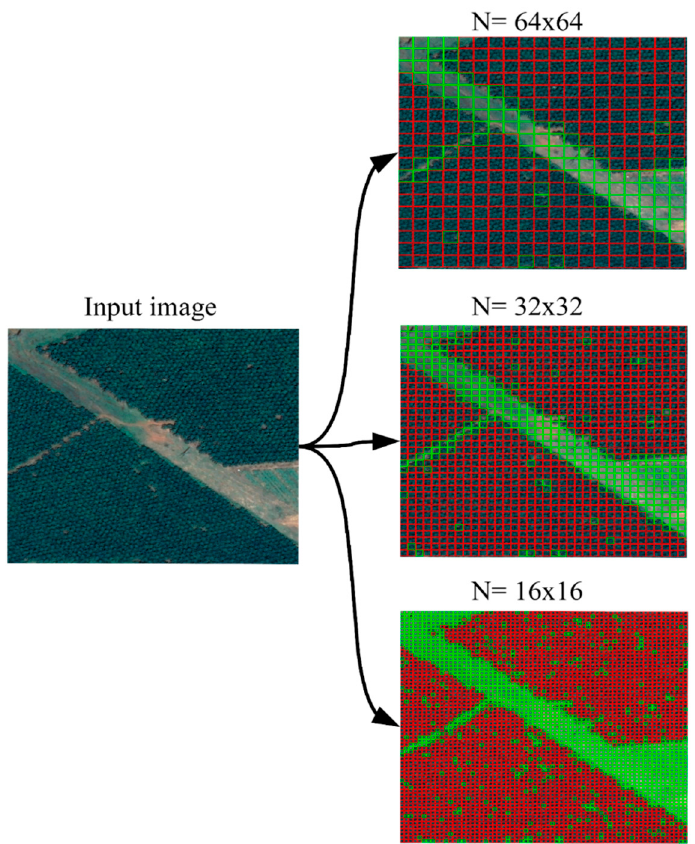
Figure A1. Vegetation encroachment detection with different patch sizes where N represents the patch size.